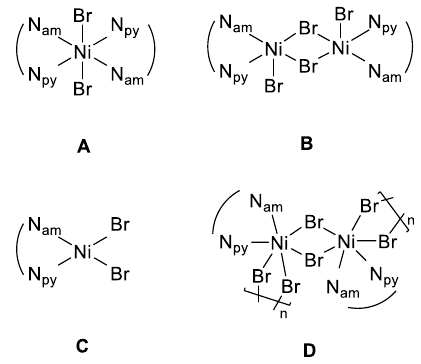
Figure 11. Various structural configurations ( A – D ) of the amine – pyridine nickel complexes.